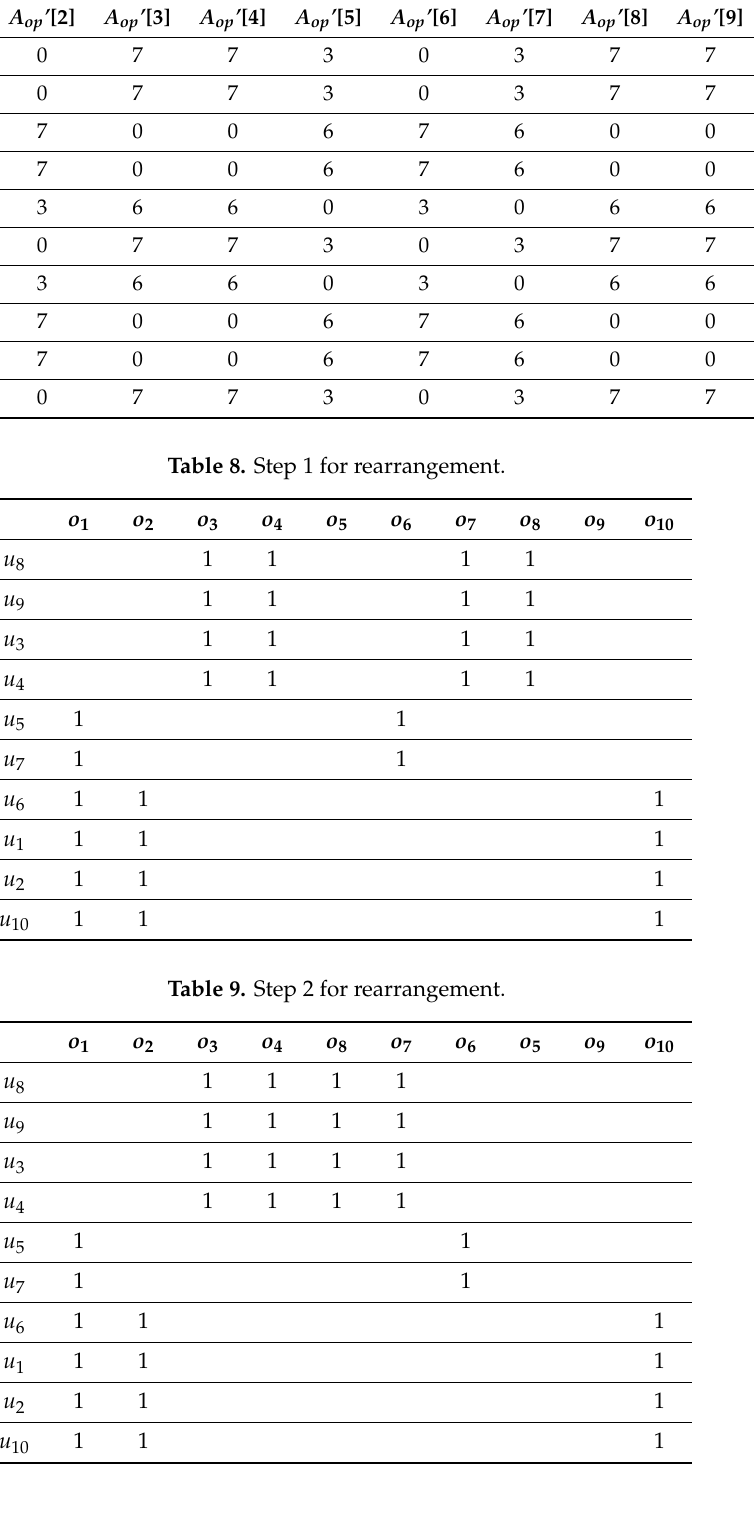
Table 7. Distance matrix D r .